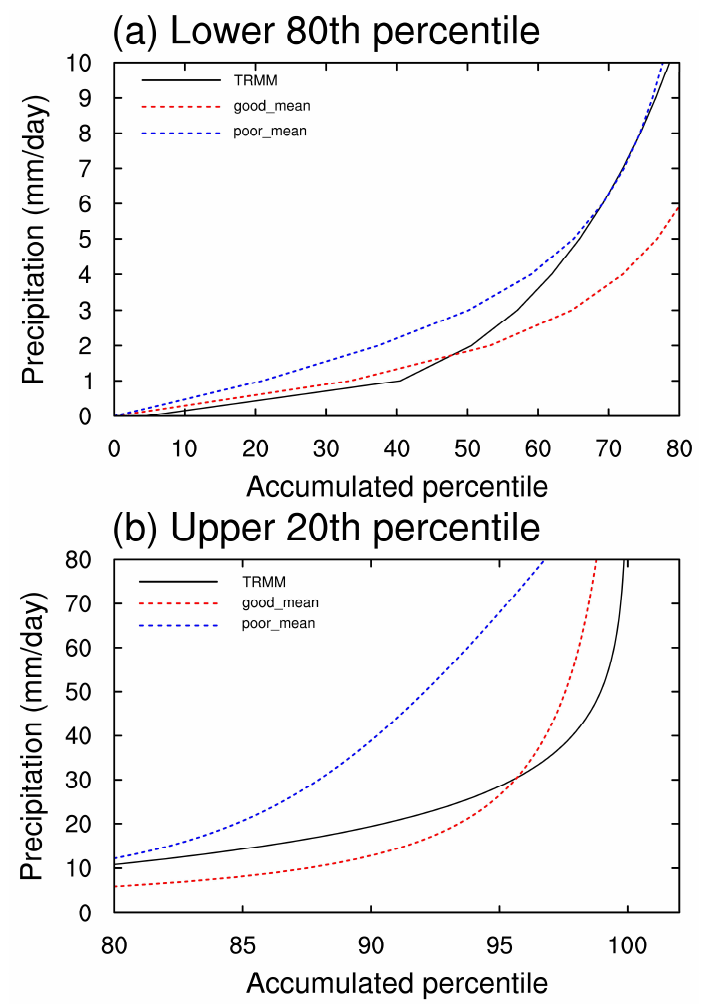
Figure 11. Histogram of precipitation (mm day ) in equatorial Indo-Pacific region (10 ◦ S–10 ◦ N; 50 ◦ E–180 ◦ ) as a function of accumulated percentiles. ( a ) Lower 80th percentile and ( b ) upper 20th percentile are plotted.